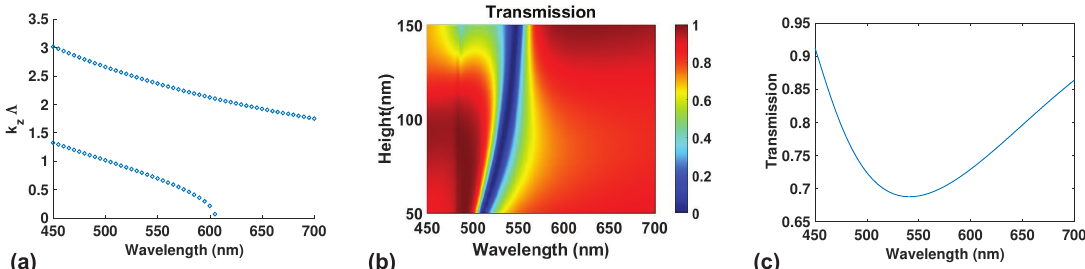
Figure 3. ( a ) Modal propagation vector in the z direction as a function of wavelength of the propagating modes in the grating structure. There is a cutoff wavelength near 600 nm below which a second mode begin to exist below this wavelength. ( b ) Plot of transmission versus wavelength for different heights of the grating structure. A reflective region exists over a wide range of height of gratings around the wavelength range of 500–550 nm. ( c ) Effective medium theory (EMT) calculation of the grating structure in Figure 1a. The minimum transmission corresponds well with the minimum position in ( b ) at a height of 100 nm.